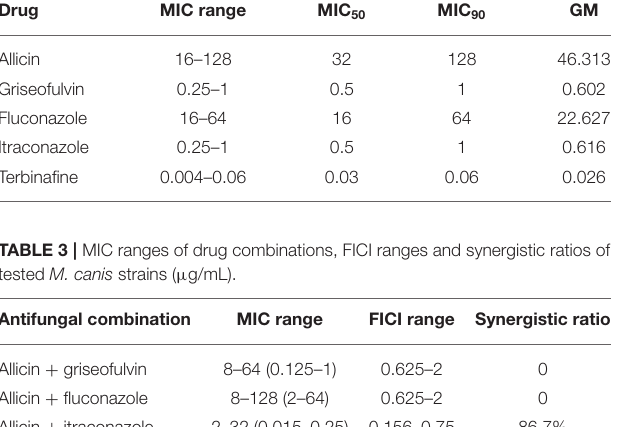
TABLE 2 | MICs of allicin and antifungal drugs tested alone against M. canis strains ( µ g/mL). Drug